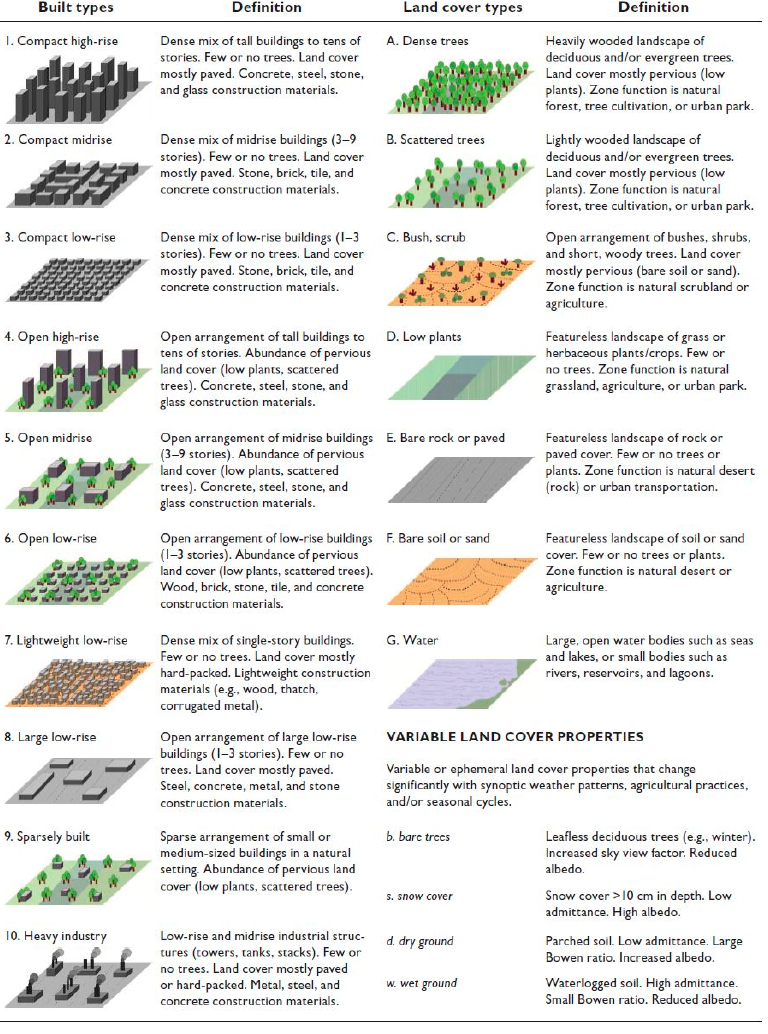
Figure 1. Built and land-cover types in Stewart and Oke’s [33] local climate zone (LCZ) classification system. Source: Stewart and Oke [33].